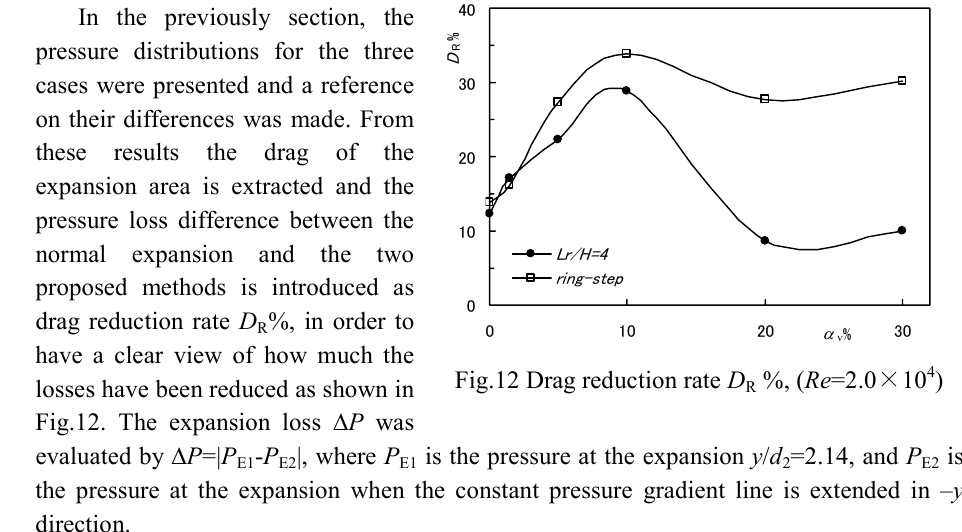
Fig.12 Drag reduction rate D